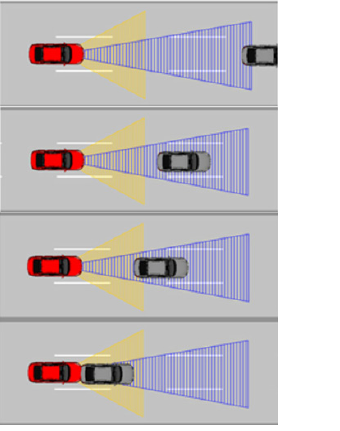
Figure 1. AEBS operations.